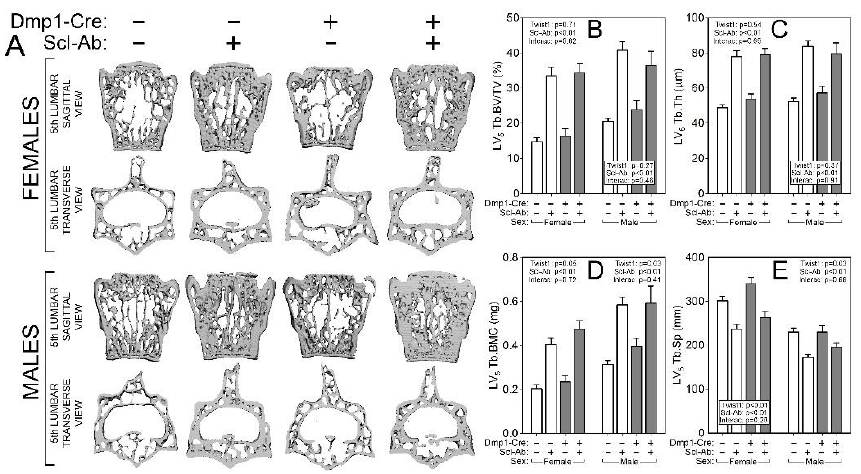
Figure 4. µCT-derived measurement of the fifth lumbar vertebral body cancellous bone from Cre-negative (white bars) and 10kb Dmp1-Cre-positive (grey bars) Twist1 f/f mice at 16 wk of age, treated with or without sclerostin antibody (Scl-Ab) for 6 wk prior to sacrifice. ( A ) Representative 3D cutaway reconstructions of the fifth lumbar vertebra in A-P view (top row) and S-I view (bottom row). Female mice are in the top of the panel, males in the bottom. Quantitative differences in lumbar vertebra 5 (LV 5 ) ( B ) trabecular bone volume fraction (BV/TV), ( C ) trabecular thickness (Tb.Th), ( D ) trabecular bone mineral content (Tb.BMC), ( E ) and trabecular separation (Tb.Sp) are shown for female (left side of each panel) and male (right side of each panel) mice. Data were tested for significance using two-way ANOVA within sex, with Twist1 status and antibody as the main effects (plus interaction), which are reported in the corner or base of each sex grouping; n = 8–11/group.